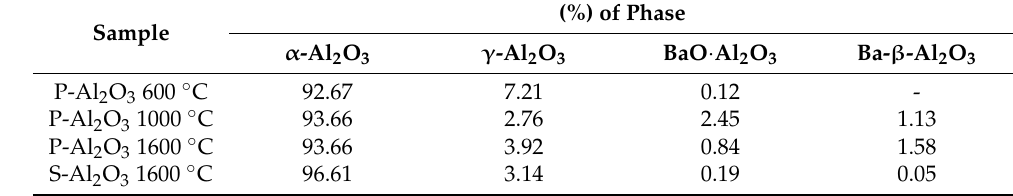
Figure 6. XRD diffractogram of powders and alumina sphere at 1600 °C.